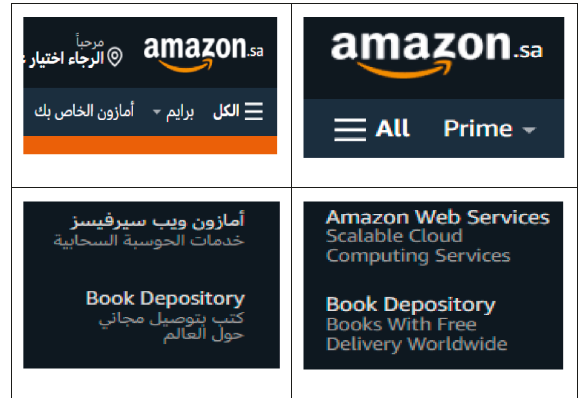
Figure 12: Examples for untranslated parts in Amazon.sa.